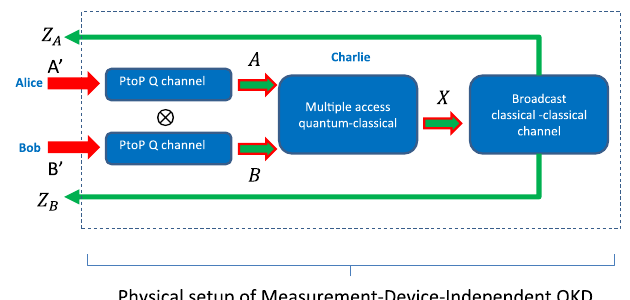
FIG. 2. Graphical depiction of a quantum-to-classical multiplex channel N MDI as a bidirectional channel, which is a A 0 B 0 → Z A Z B composition of three elementary multiplex channels. We show a pair of point-to-point channels from Alice to Charlie, and from Bob to Charlie composed of a multiple access quantum-to- classical channel (quantum instrument) performed by Charlie, followed by a broadcast classical channel back to Alice and Bob. The green arrows with red boundaries are the outputs of one multiplex channel, which are, at the same time, inputs to the other channel, hence the